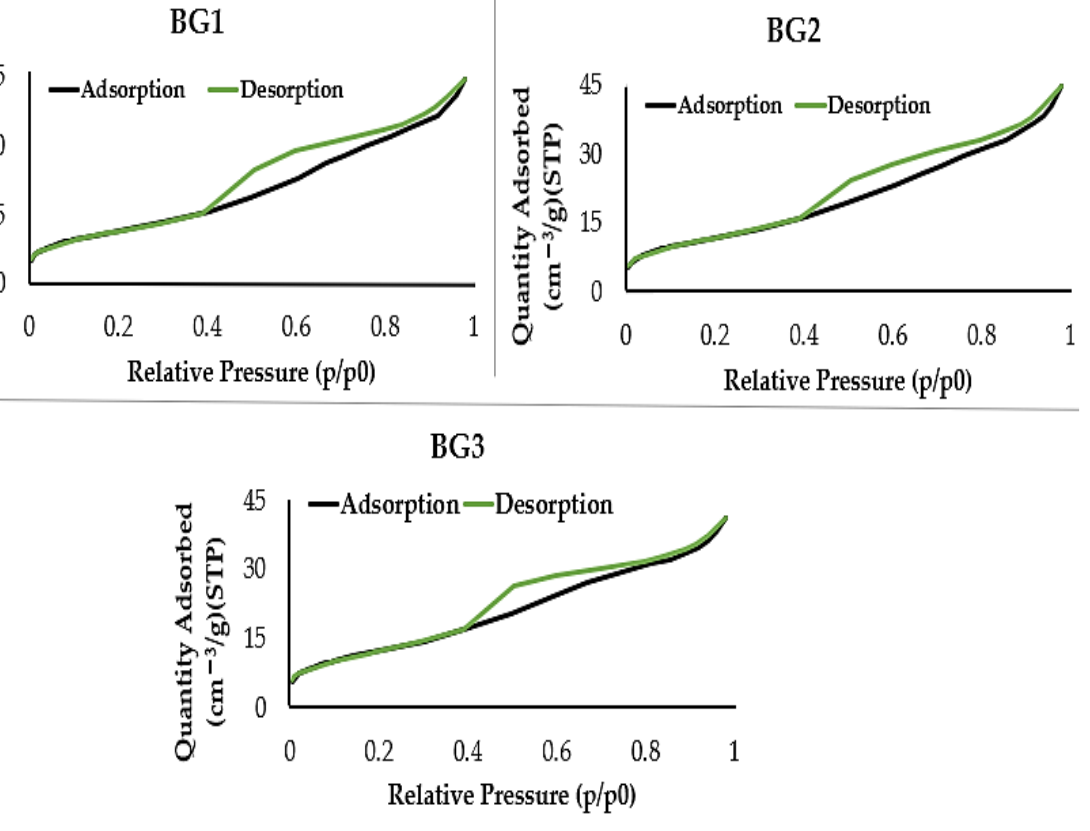
Figure 4. Adsorption and desorption isotherm curves of BG1, BG2, and BG3 powder samples, calcined at 700 °C.